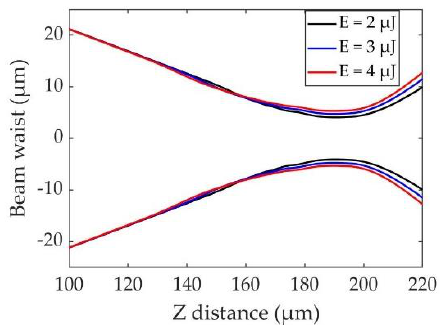
Figure 4. Beam waist evolution due to self-focusing and defocusing in Nd:YAG.